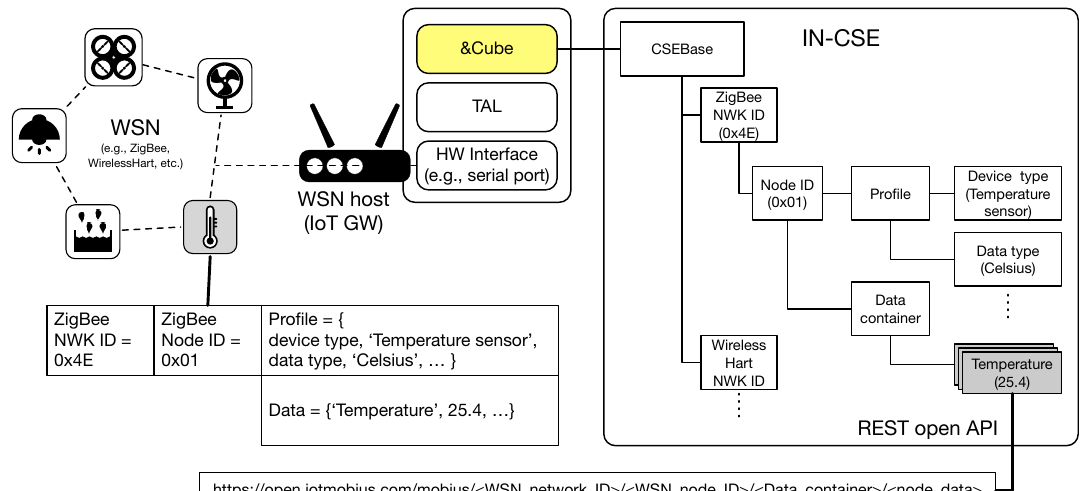
Employing oneM2M platforms (i.e., Mobius and &Cube) and TAS for extending previously-existing WSN (e.g., ZigBee, WirelessHART) systems towards the Web of Things